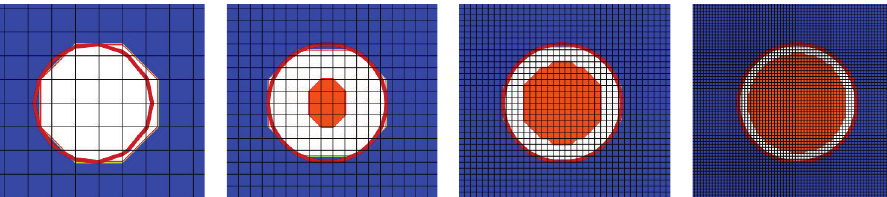
Figure 7: Computational meshes around a cylinder ( 𝑑𝑥 = 0.2 𝐷 , 0.1 𝐷 , 0.05 𝐷 , 0.025 𝐷